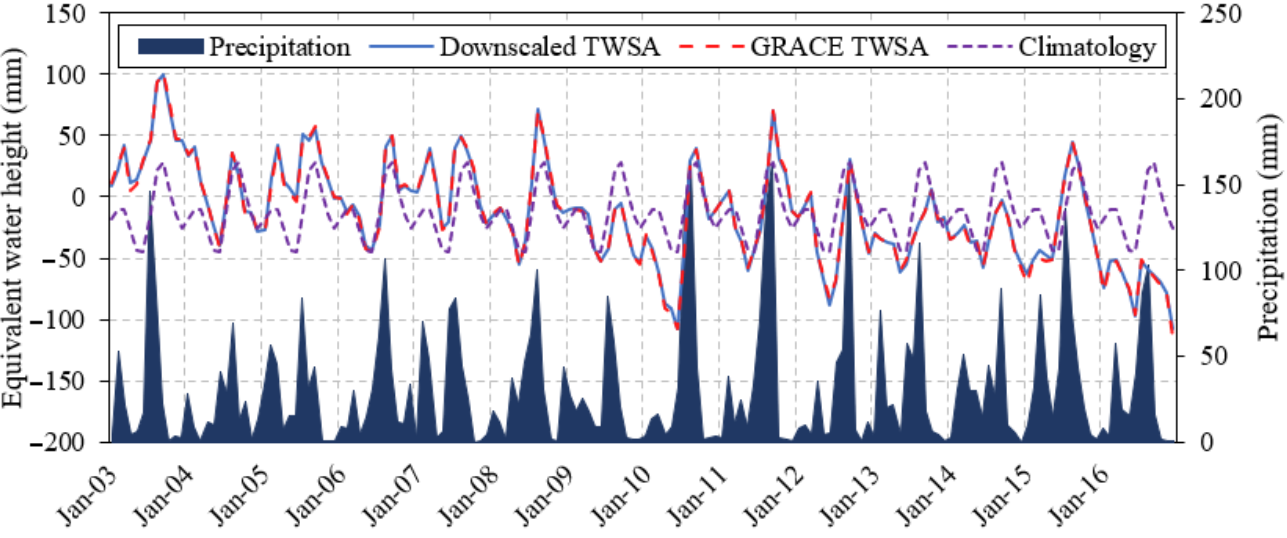
Figure 4. The sensitivity of the XGBoost model to the independent variables in predicting TWSA.